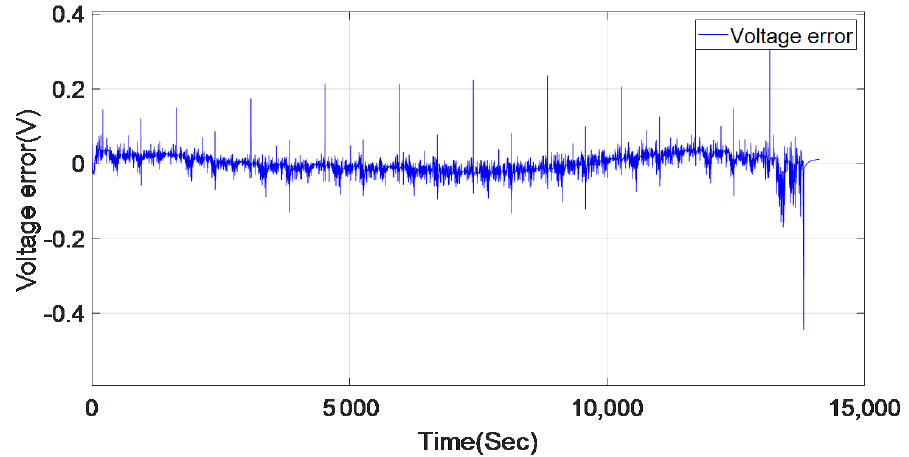
Figure 9. Measured minus simulated model